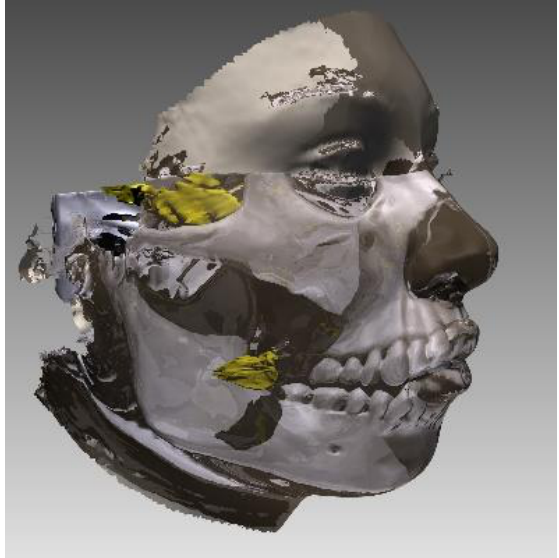
Figure 3. The temporal process of buccal fat pad: temporal and buccal processes.